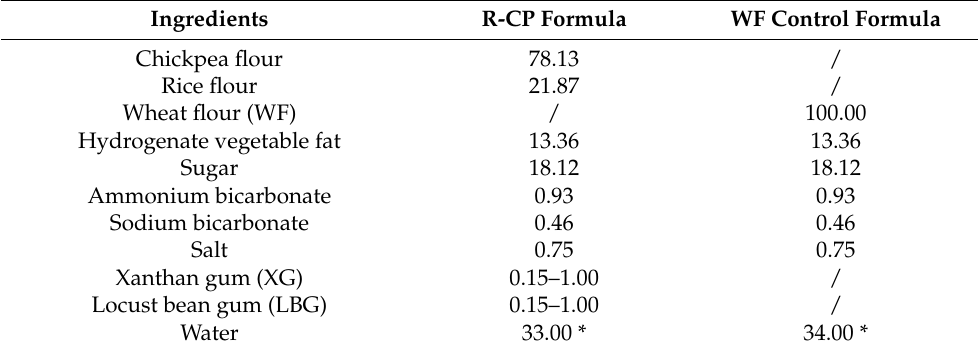
Table 2. Ingredients of biscuits based on rice-chickpea composite flour (R-CPF) and wheat flour (WF) with varying xanthan gum (XG) and locust bean gum (LBG) gum levels, expressed in (%) (composite-flour weight